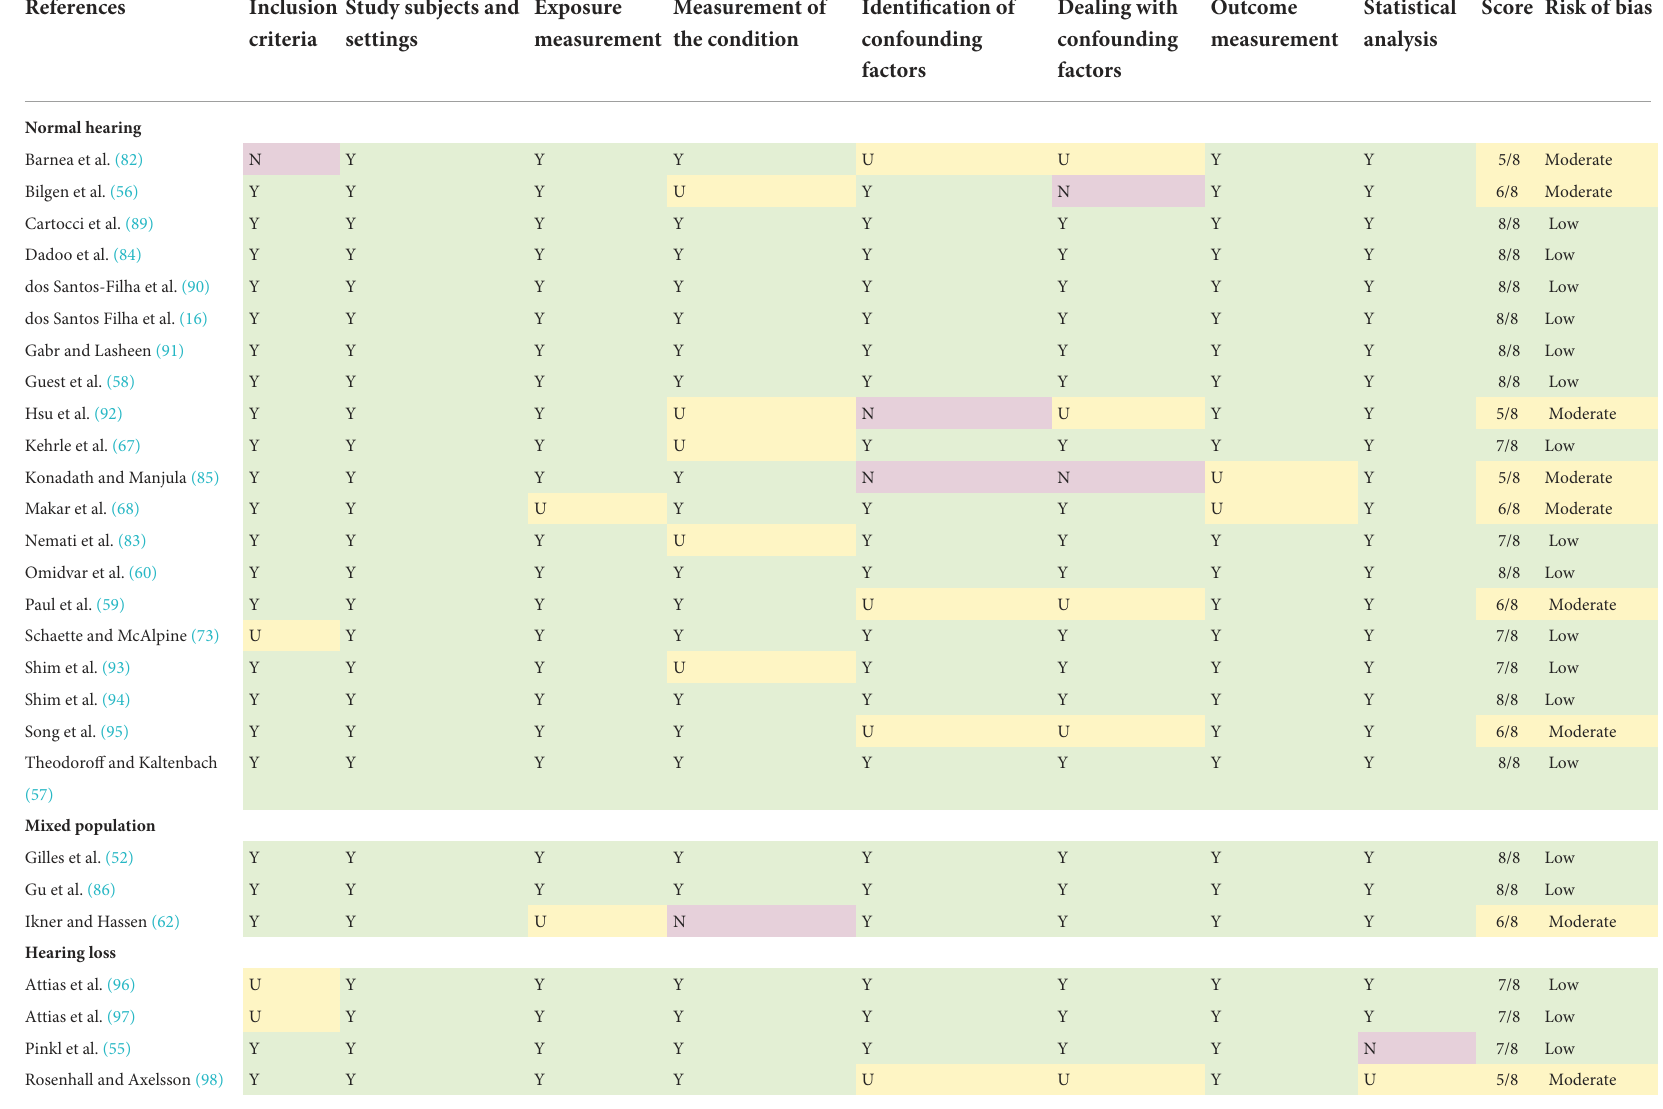
TABLE 1 JBI checklist for analytical cross-sectional